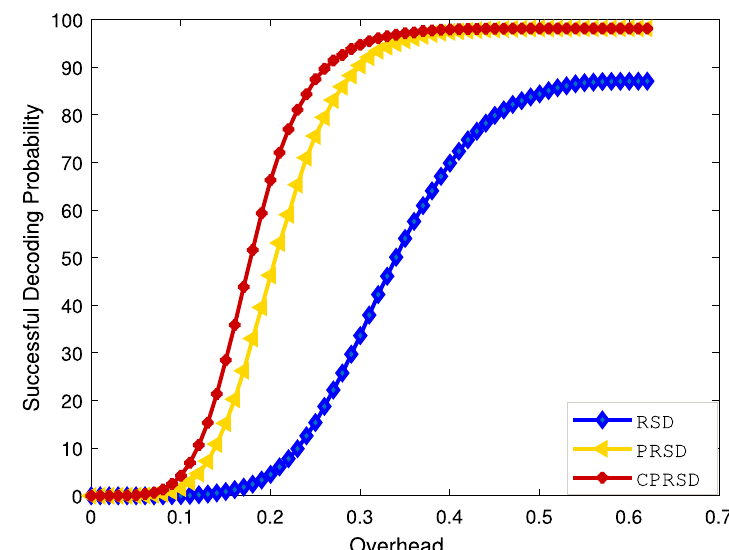
Fig. 8 Successful decoding probability for k = 100 in non-removal state